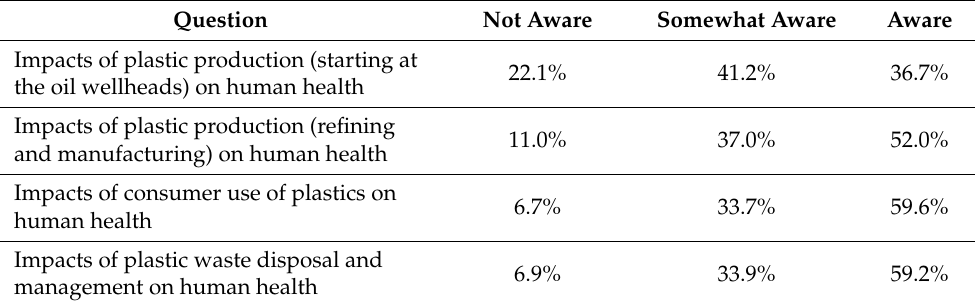
Table 3. Awareness about the direct and indirect impact of plastics on human